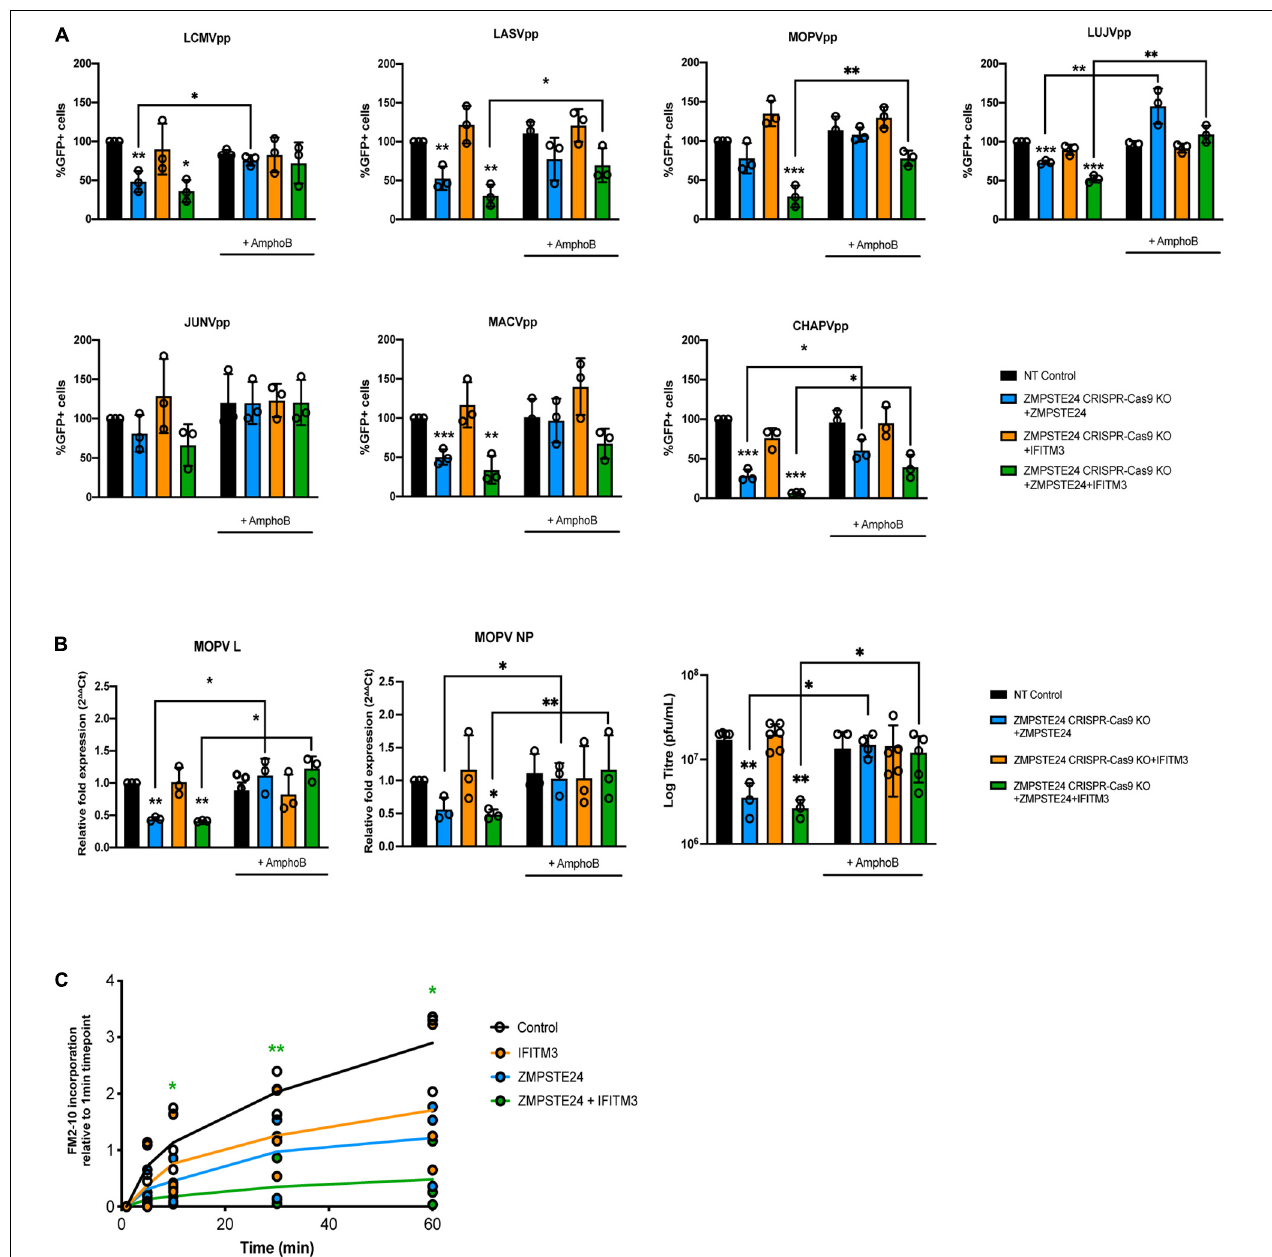
FIGURE 5 | ZMPSTE24 and IFITM3 modulate membrane fluidity to restrict arenaviruses. A549 CRISPR-Cas9 non-targeting (NT) or ZMPSTE24 knockout (KO) cells were transduced for stable expression of ZMPSTE24-FLAG, IFITM3 or both. Cells were incubated with 1 µ M Amphotericin B (AmphoB) for 1 h prior to infection with (A) arenavirus GPpp for 48 h or with (B) MOPV (MOI = 0.01) for 72 h. GPpp infectivity was measured as %GFP positive by flow cytometry. MOPV L and NP gene expression was measured by RT-qPCR from extracted RNA while infectious virus production was measured by plaque assay from cell supernatants. (C) A549 cells stably expressing ZMPSTE24-FLAG, IFITM3 or both were incubated with 200 nM FM TM 2-10 for indicated time points and FM TM 2-10 incorporation was measured as fluorescence intensity of incorporated membrane probe by flow cytometry. Data are shown as mean ± SE (standard error) of n = 3 independent experiments. Significance is indicated as p -values *** p < 0.0001, ** p < 0.001, * p <